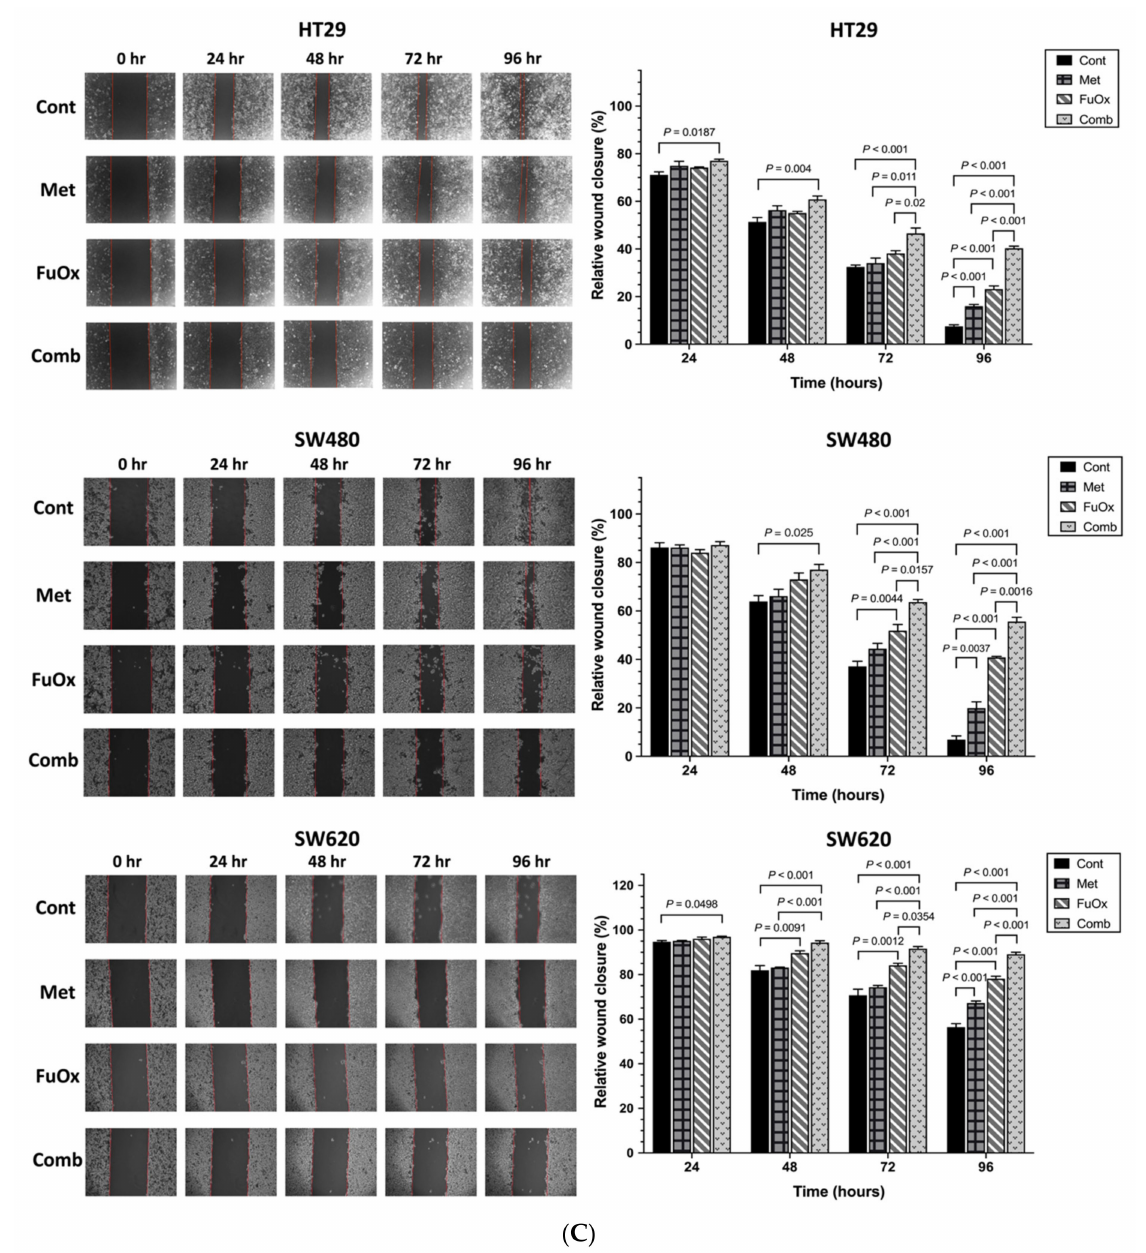
Figure 2. Metformin increases FuOx inhibition effect on cell proliferation, clonogenic growth, and migration. ( A ) Cell proliferation was measured using CCK-8 assay after cells were treated with the indicated concentrations of FuOx with or without metformin for 72 h; ( B ) cells were plated in 6-well plates at a density of 10,000 cells per well and were treated with metformin (5 mM), FuOx (2 µ M), and the combination of metformin and FuOx. The number of colonies was counted after 7 days of treatment; ( C ) for migration assay, cells were added into each well of the 2-well culture-inserts in 12-well plates. When the cells had grown to 95% confluence, the 2-well culture-inserts were removed, and the cells were incubated in a medium with drugs for 96 h. Data are presented as mean ± SEM; *** p < 0.001. Cont, control; Met, metformin; FuOx, 5FU and oxaliplatin; Comb, combination of metformin and